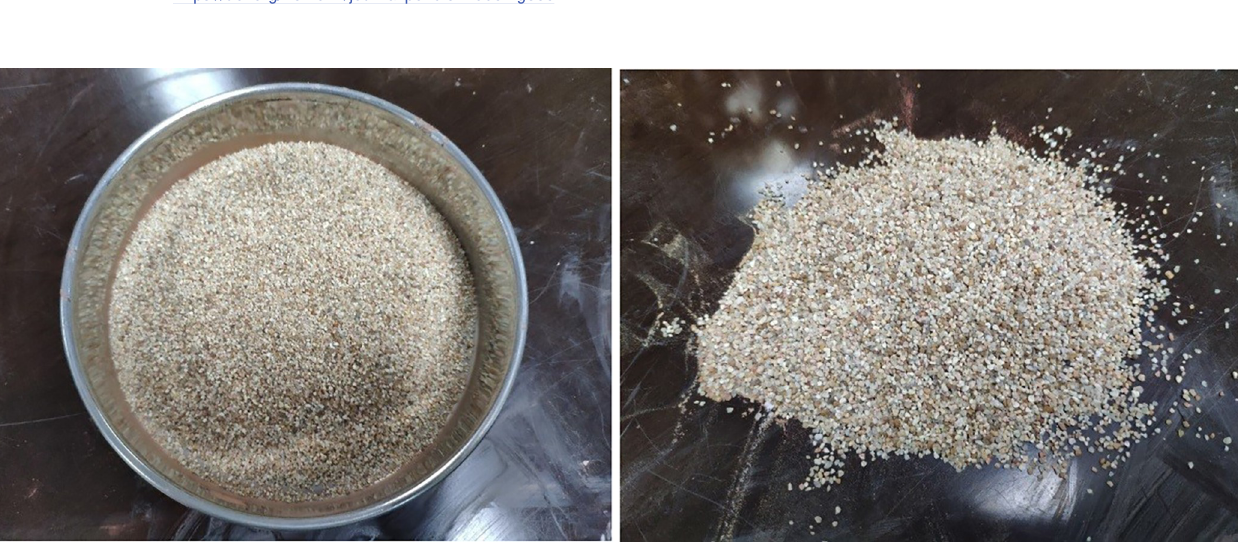
PLOS ONE | https://doi.org/10.1371/journal.pone.0275867 October 10, 2022 8 /